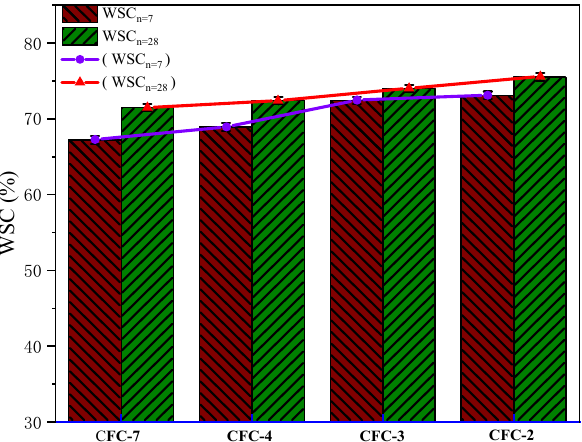
Figure 8. Water stability coefficient of calcium silicate slag stabilized base material.